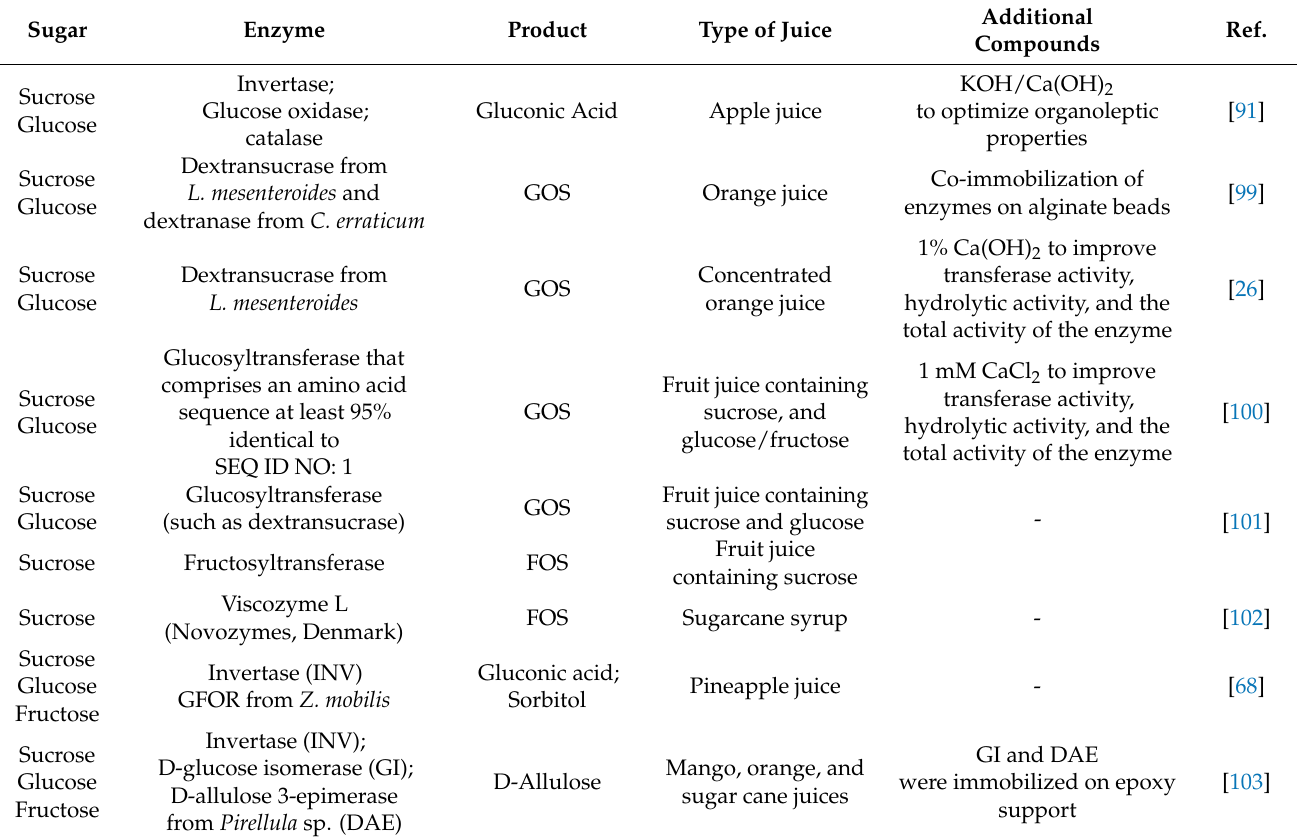
Table 4. Comparison of enzymes applied to reduce sugar content in